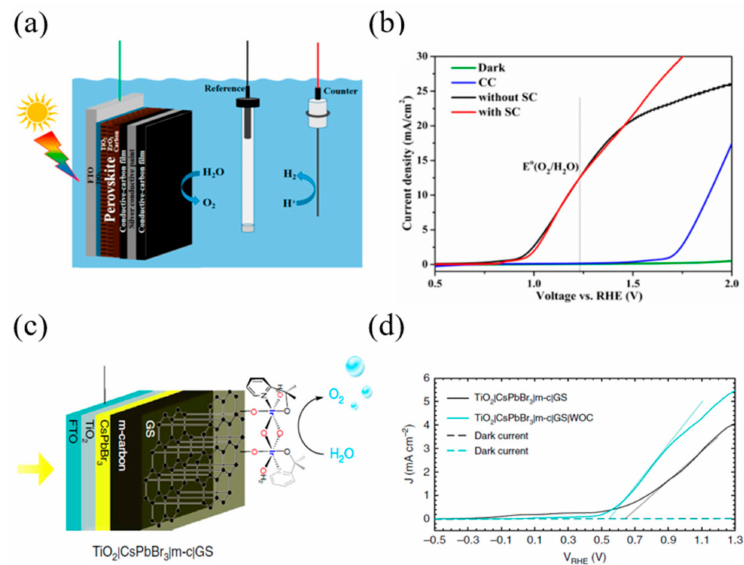
Figure 5. Examples of the n–i–p configuration of perovskite-based PEC cells. ( a ) Schematic illustration of the perovskite photoanode for PEC water splitting in a standard three-electrode system. ( b ) Voltammogram of perovskite photoanodes with SC paint layer (red curve) and without SC paint layer (black curve) under simulated illumination and in the dark (green curve), with the CC paste electrode (blue curve) as a reference. ( c ) Schematic illustration of perovskite photoanode device used CsPbBr 3 , TiO 2 (electron collecting), m-carbon (hole collecting). ( d ) Linear sweep voltammetry (LSV) of a TiO 2 | CsPbBr 3 | m-c | GS and a TiO 2 | CsPbBr 3 | m-c | GS | WOC measured at a scan rate of 20 mV s − 1 , in